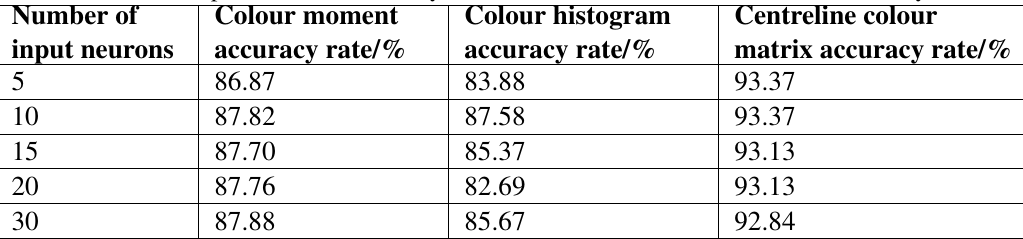
Fig. 4 BP neural network model. Table 1 Comparison of the accuracy of the number of neurons in different hidden layers